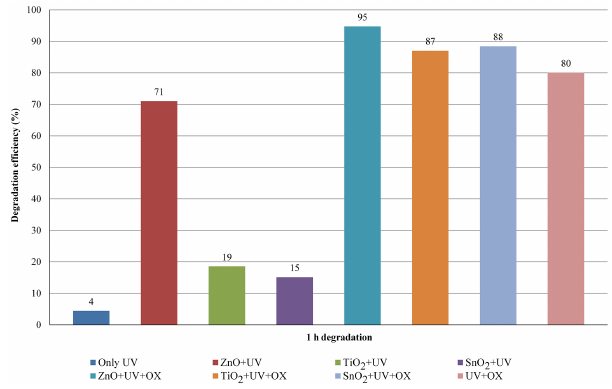
Figure 12. Degradation performance of different methods for re- moving BPA from